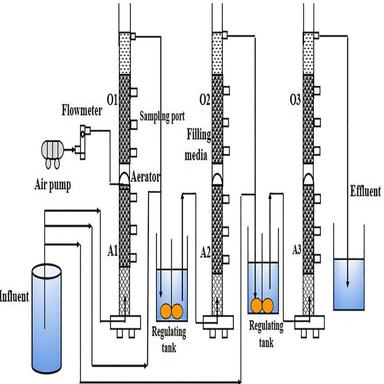
Schematic diagram of the SFTIAOB process.